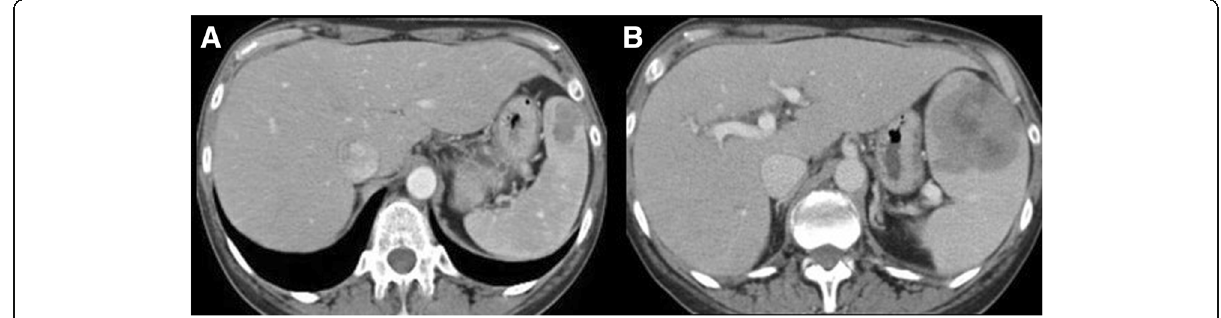
Fig. 4 A 65-year-old woman with Waldenstrom macroglobulinemia treated with chemotherapy and hematopoietic stem cell transplant and new onset fever, neutropenia, and increased LDH. a Axial CT image acquired during portal venous phase six months before the onset of new symptoms shows a hypodense lesion in the spleen. b Axial CT image acquired during portal venous phase at the time of symptom onset shows increased size and decreased density of the splenic lesion. Biopsy of the lesion confirmed histologic transformation to diffuse large B cell